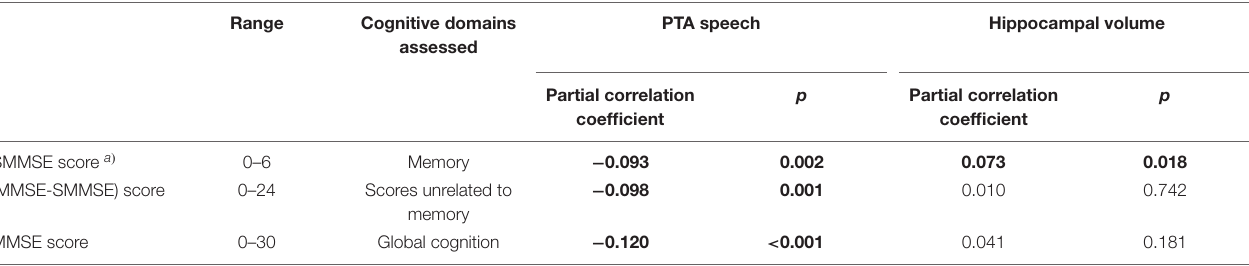
TABLE 4 | A subgroup analysis to assess the relationship of cognitive function with hearing and with hippocampal volume, using Pearson partial correlation analyses (Only over 60 years old, N =